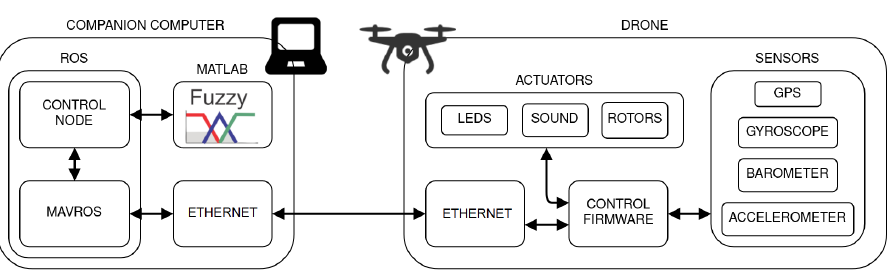
Figure 3. Signal flowchart and